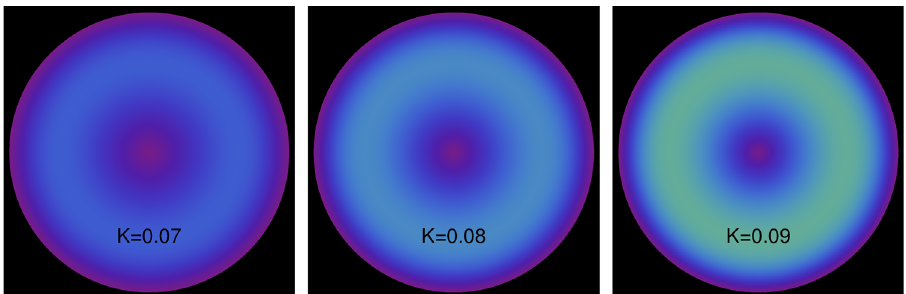
Fig. 8 Radial pressure [ 6 ˜ p ( r ) × 10 3 ] for n = 0 . 2 and r three different values of K